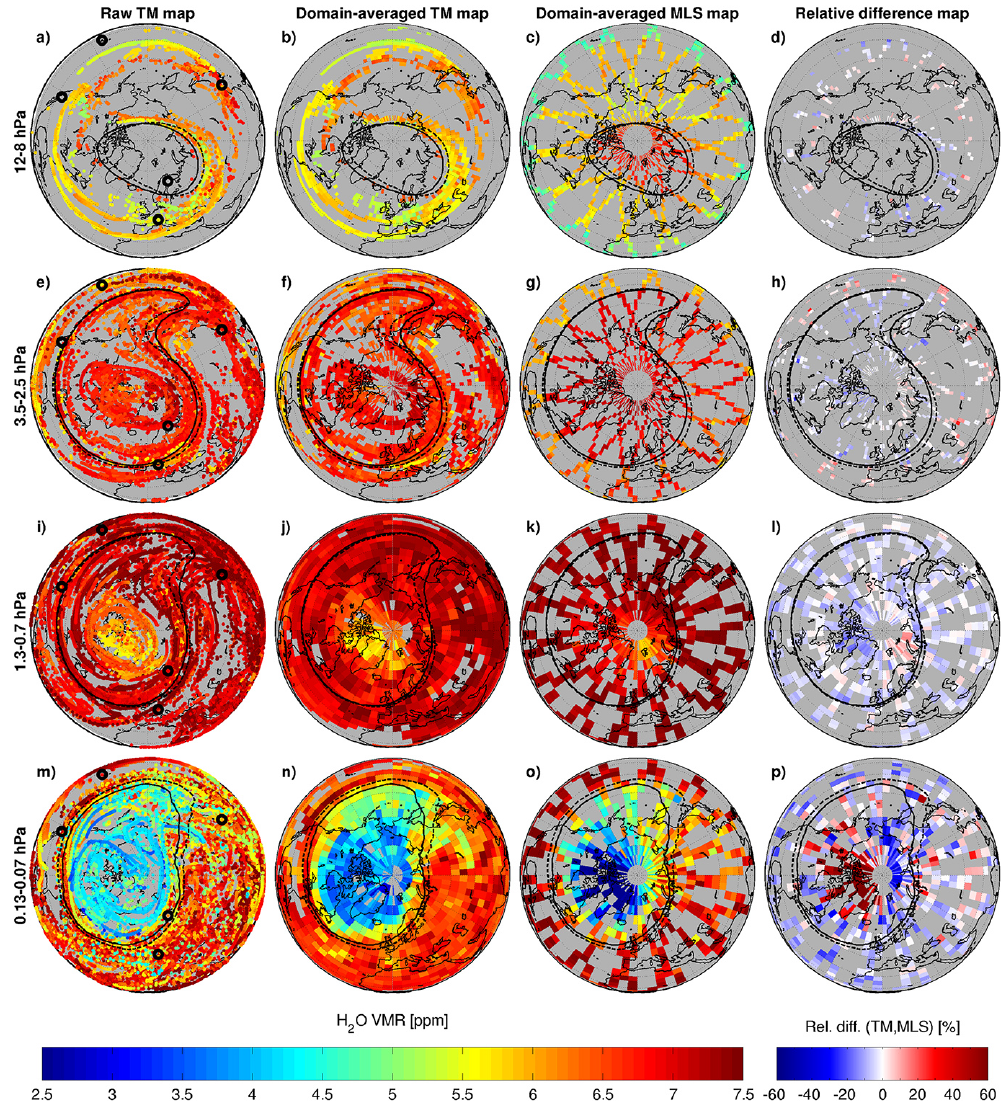
Figure 3. Case A: stratospheric H 2 O VMR [ ppm ] within 12 to 8 hPa (a–c) , 3 . 5 to 2 . 5 hPa (e–g) , respectively mesospheric H 2 O VMR within 1 . 3 to 0 . 7 hPa (i–k) , 0 . 13 to 0 . 07 hPa (m–o) on 28 February 2012 12:00UTC. Harmonized trajectory-mapped ground-based measurements from five stations (black circles) corresponding to Bern, Seoul, Hawaii, Table Mountain and Sodankylä are displayed in raw (first column), with 2 . 5 ◦ × 2 . 5 ◦ (first and second row) or 5 ◦ × 5 ◦ (third and fourth row) domain-averaged format (second column). Pressure layer and domain-averaged Aura MLS v3.3 observations are shown in the third column. Relative difference maps of coincident domains between TM and Aura MLS data are shown in the fourth column. All charts indicate the position and vertical displacement of the polar vortex edge within the given pressure layers by the solid black (upper p limit) and dashed black (lower p limit) lines. Grey areas indicate no data